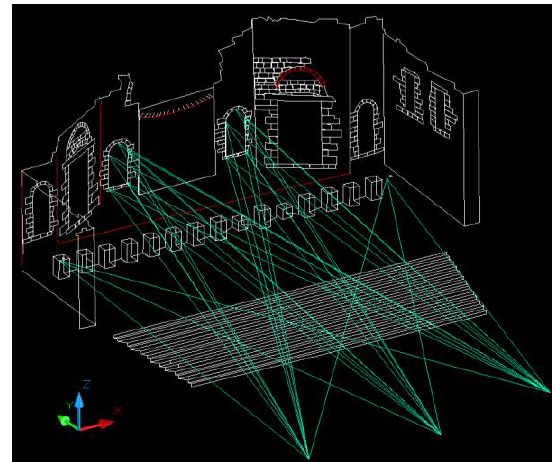
Figure 9 - Shabba the ancient forum (plot by V.Cori). The three panoramas points are visible together with the orientation directions.